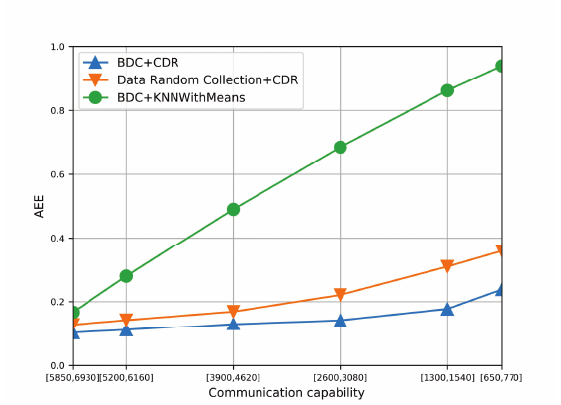
Figure 9. The AEE of three algorithms under different communication